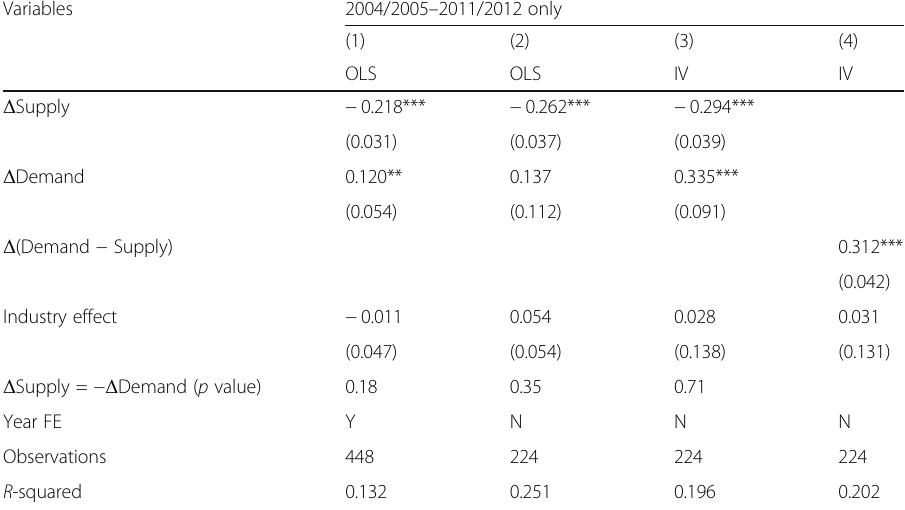
Table 3 Regression analysis